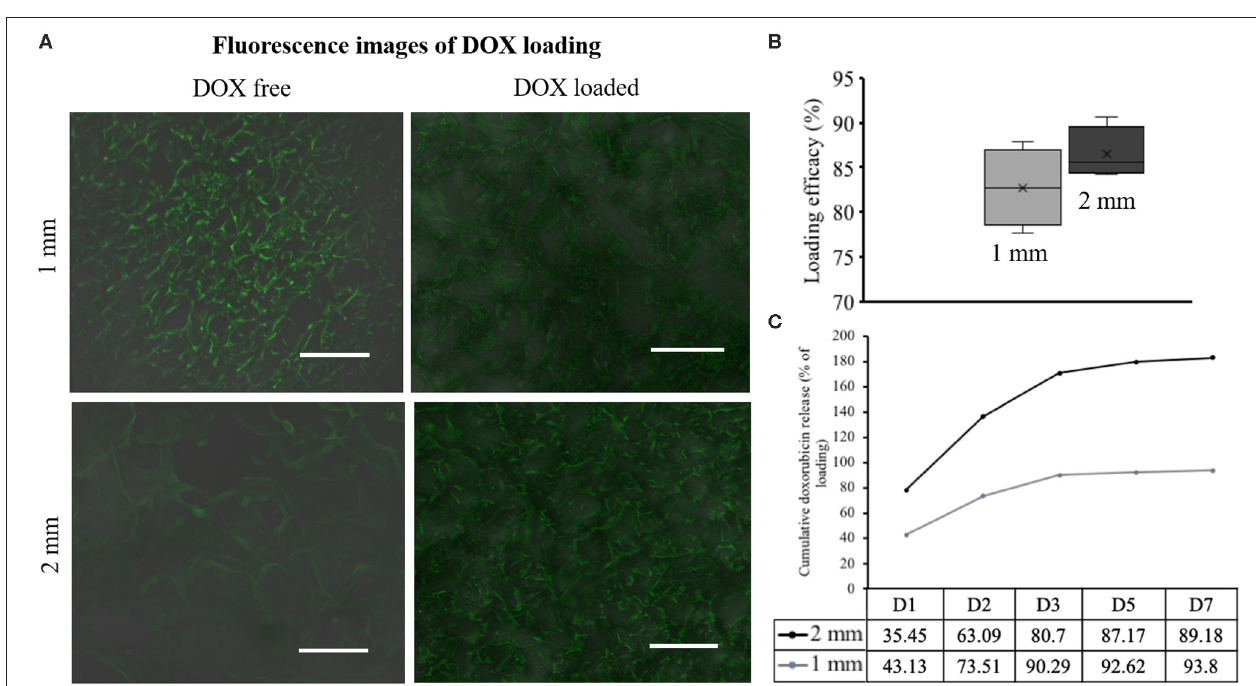
FIGURE 3 | Diffusion profile of doxorubicin (DOX) in the Silk fibroin (SF) scaffolds. DOX is loaded in the SF scaffold and the confocal images are shown together with a DOX free scaffold. It is evident from the SF auto-fluorescence (A) . Loading efficiency in both 1 and 2mm scaffolds is evaluated (B) . Cumulative DOX release curve represents the DOX release along 7 days, which is measured by mean of spectrophotometric technique ( n = 3) (C) .